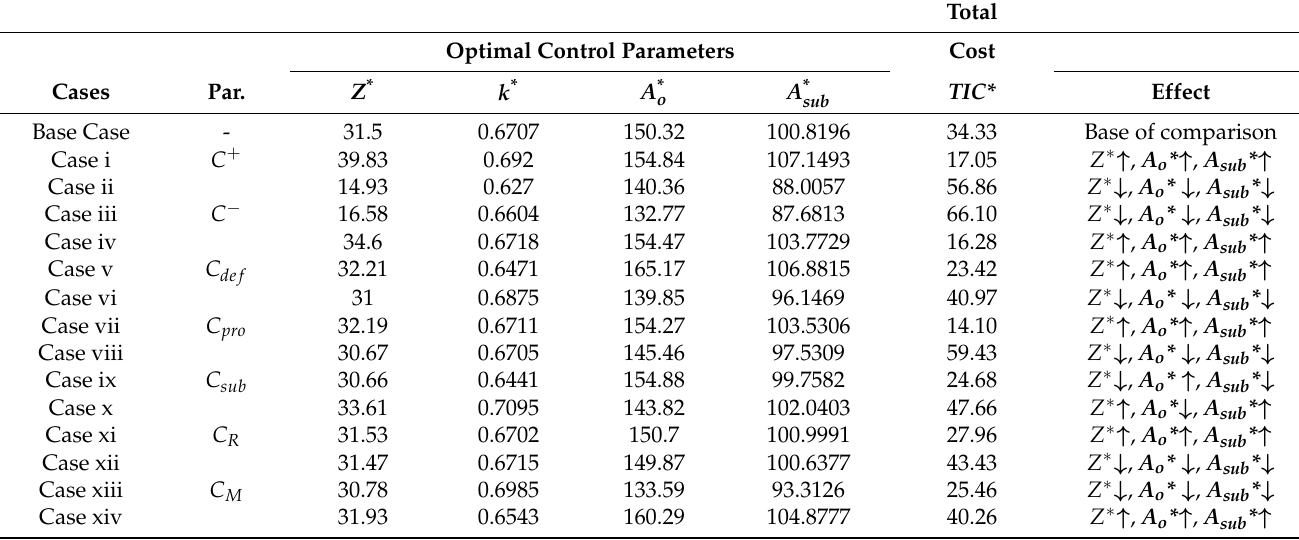
Table 8. Sensitivities for the cost